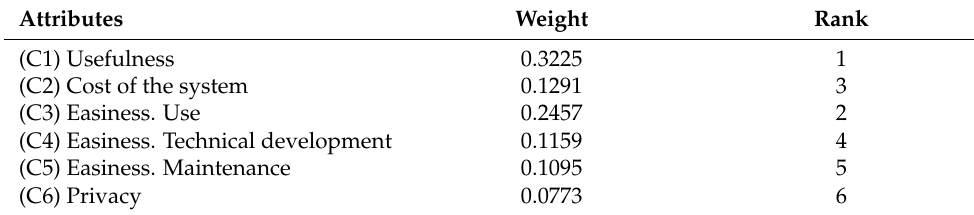
Table 10. Significance and ranking of the attributes.